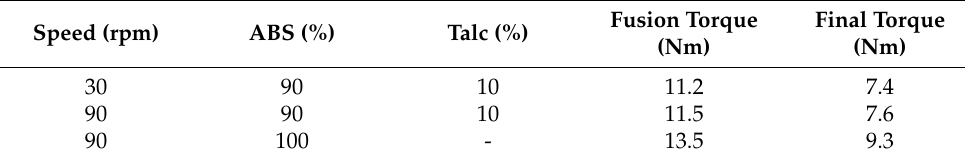
Figure 3. Effect of talc filler on fusion time fusion torque of ABS composites. Table 3. ABS/talc composites’ composition, fusion torque, and final